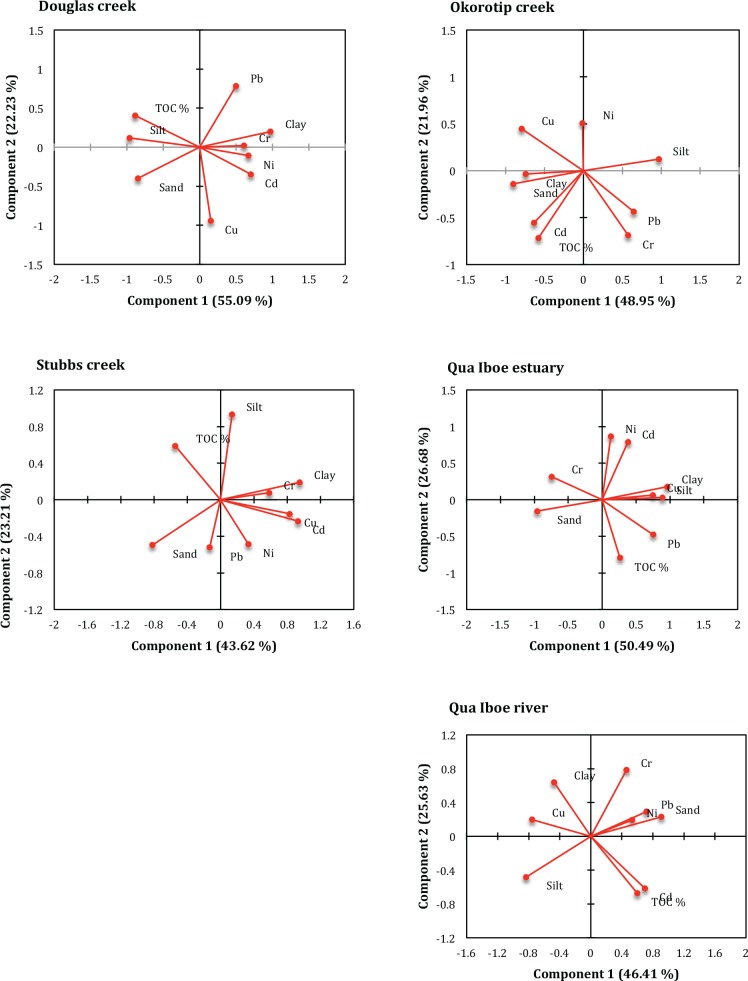
The two principal components calculated by PCA reflecting the relationship of investigated trace metals and sedimentary variables.